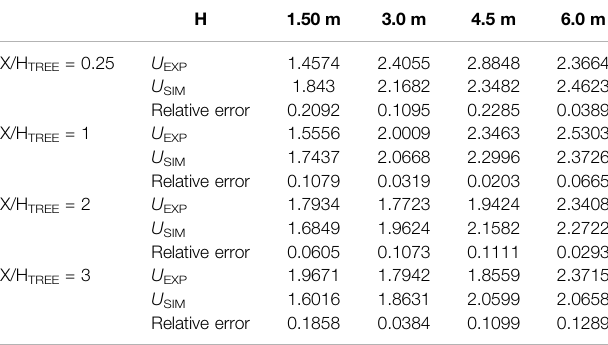
TABLE 4 | Comparison of wind speed measurement (AIJ) and numerical simulation.